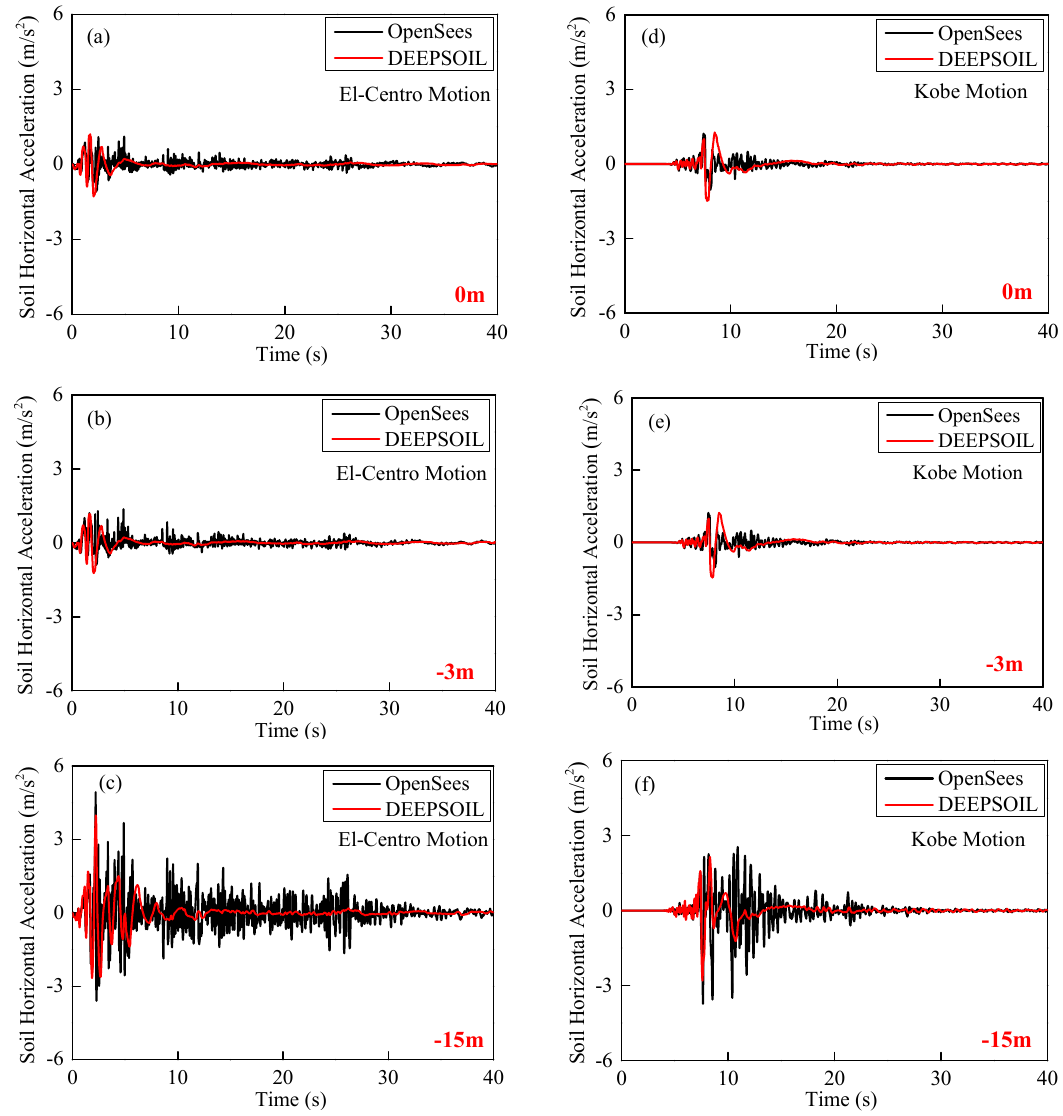
Figure 15. Time history curves of acceleration responses: ( a ) 0 m; ( b ) −3 m; ( c ) −15 m under the El-Centro motion and ( d ) 0 m; ( e ) −3 m; ( f ) −15 m under the Kobe motion.